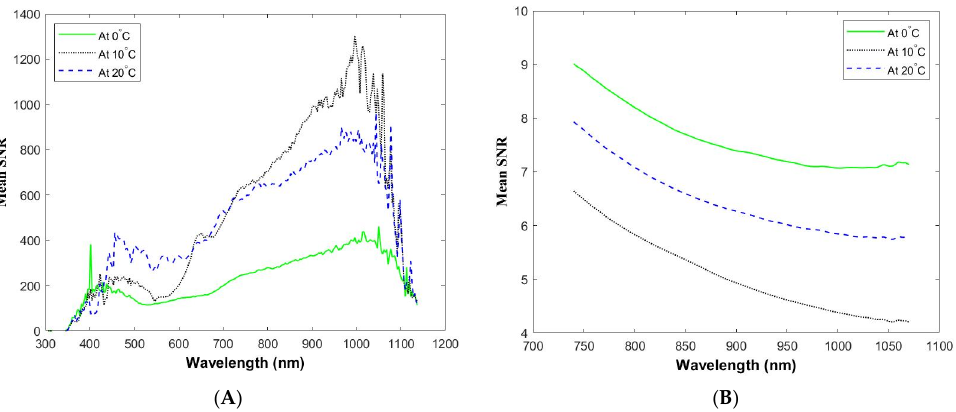
Figure 6. Mean signal-to-noise ratio (SNR) of Teflon absorbance spectra measured at di ff erent room temperatures with the F-750 meter ( A ) and with the SCiO meter ( B ), across their respective full wavelength